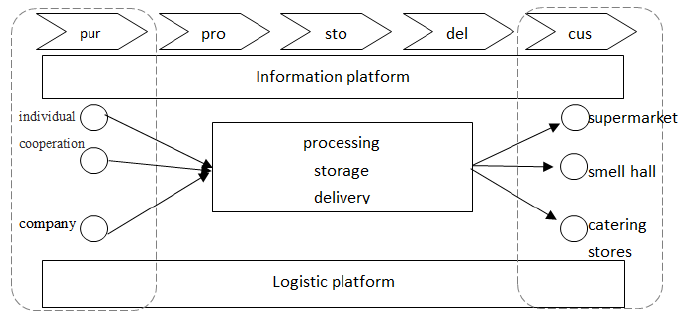
Figure 1. The service-oriented catering supply